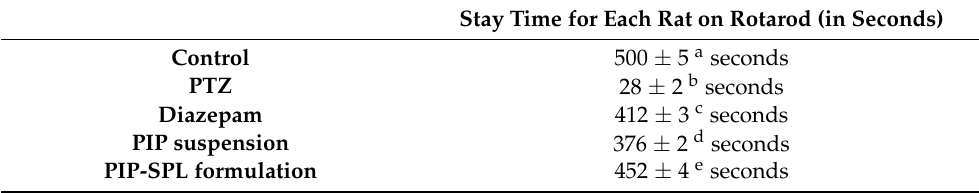
Table 6. Effect of different treatments on neuromuscular coordination. Stay Time for Each Rat on Rotarod (in Seconds) Control